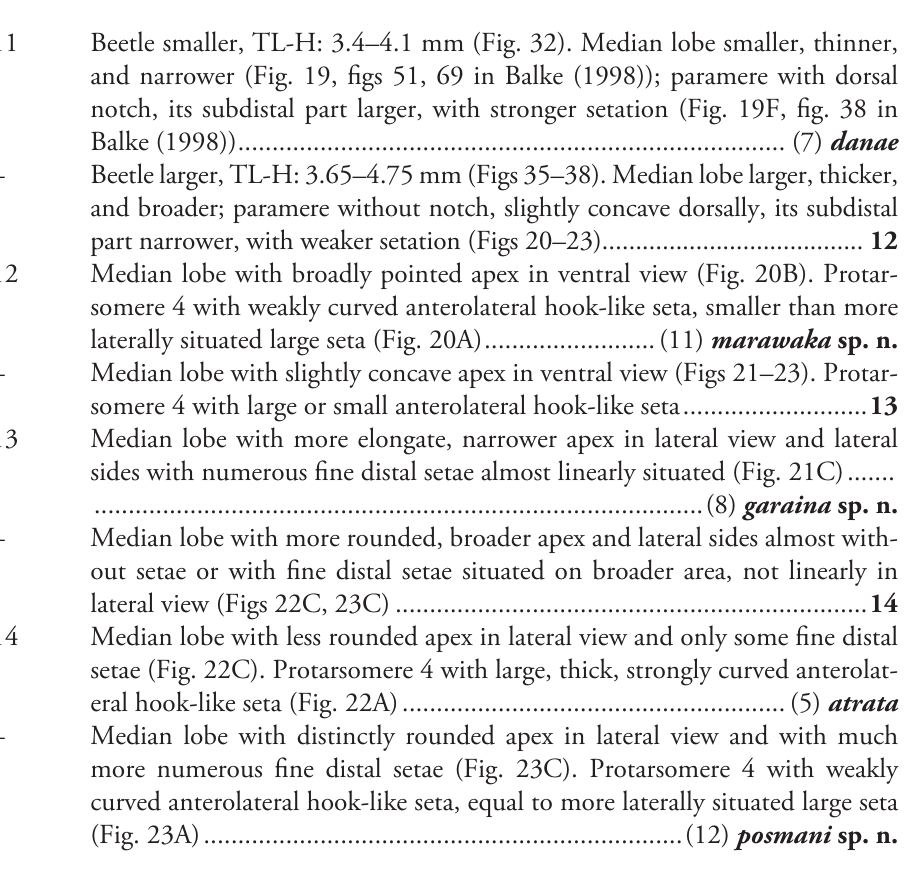
eral hook-like seta (Fig. 22A) ........................................................ (5) atrata